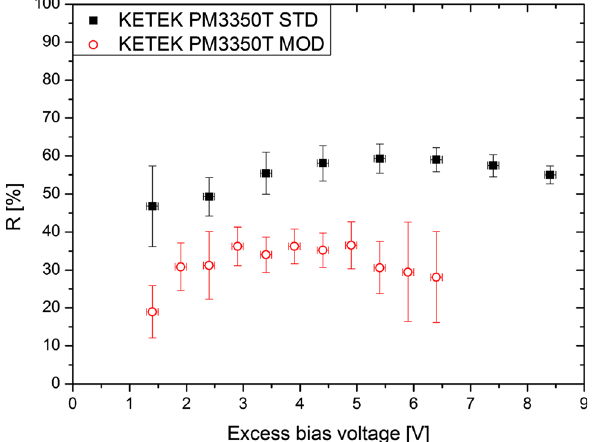
Fig. 16 Average light emission intensity per hotspot as a function of Δ V